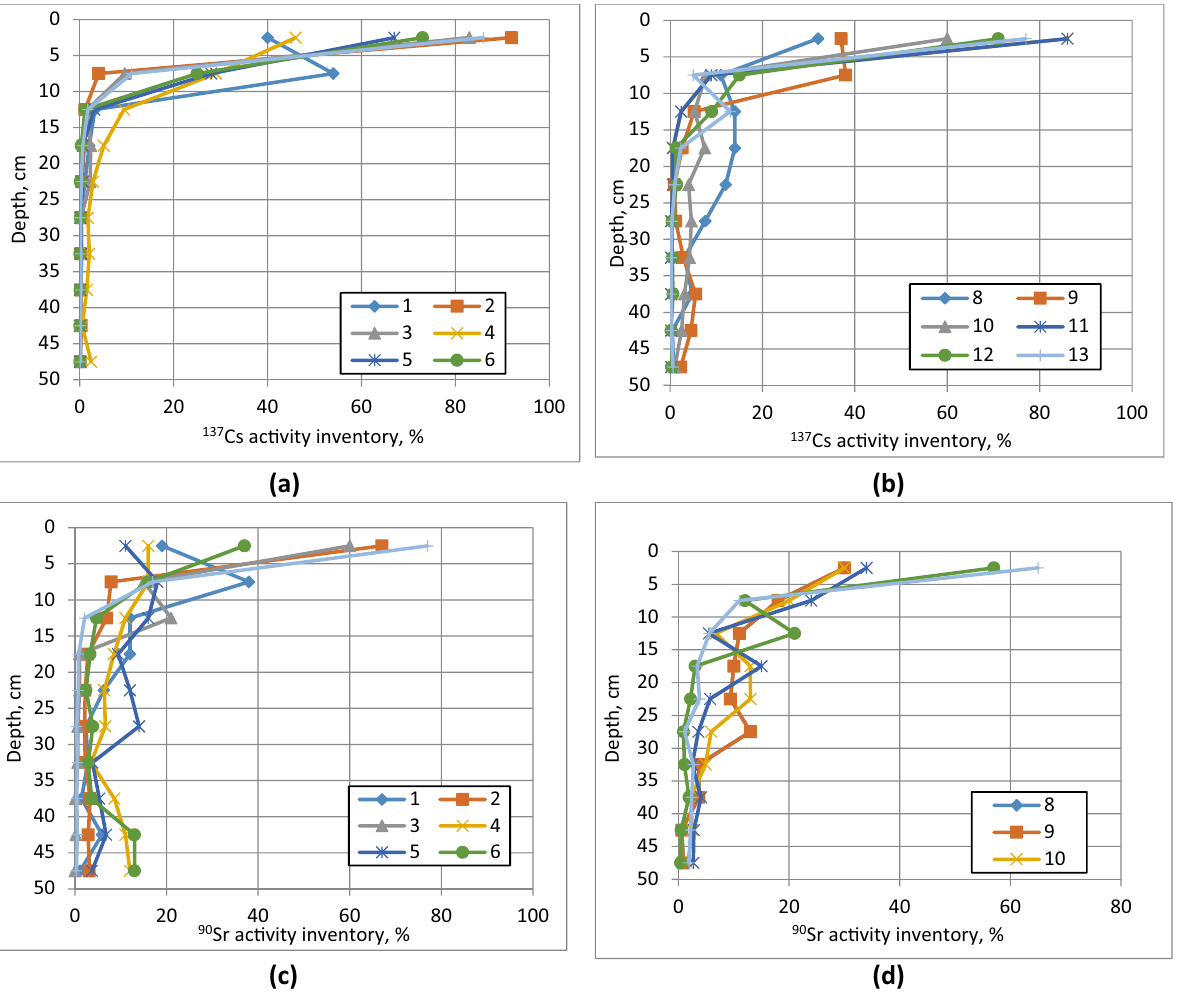
Figure 2. Vertical distribution of 137 Cs (( a ), ( b )) and 90 Sr (( c ), ( d )) in soils of landscape polygons of “Ecocenter” in the CEZ in 2020. The analytical error of 137 Cs and 90 Sr activity measurements is 20–30%. The landscape polygons (LP) no.1–4, 11 and 12 are situated within the glacial plateau; LP no.5, 7,8, 10 and 13 are situated within the terrace of the Pripyat River; LP no.6 and 9 are situated within the floodplain of Pripyat River. (Map showing location of sampling sites is given in Supplemental Information, Figure